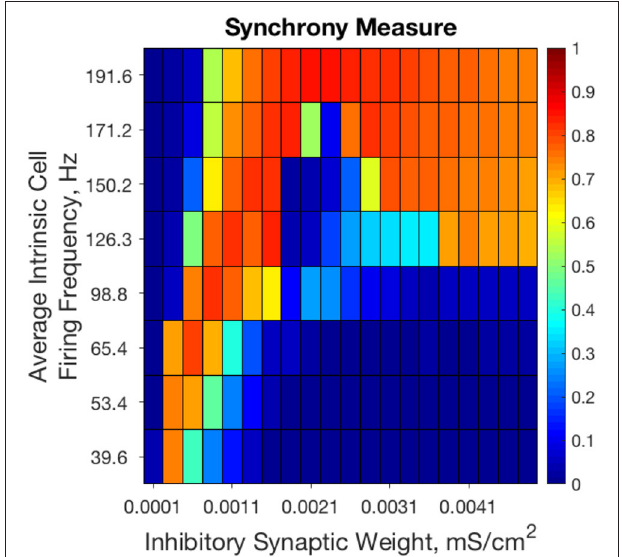
FIGURE 2 | Randomly connected strictly inhibitory networks of Type I neurons with strong and weak inhibitory connectivity synchronize in divergent parameter regimes. Synchrony measure computed from dynamics of strictly inhibitory networks consisting of Type I neurons as synaptic weight (x-axis) and average intrinsic cell firing frequency (y-axis) are varied. Only networks with very weak inhibitory synaptic weight exhibit synchronous activity when average intrinsic cell firing frequency is low. Networks with stronger inhibitory synapses only synchronize when average intrinsic cell firing frequency is higher. Inhibitory synaptic weights stronger than those shown here simply continue the pattern of synchronous behavior shown for networks with an inhibitory synaptic weight above 0.0041 mS/cm 2